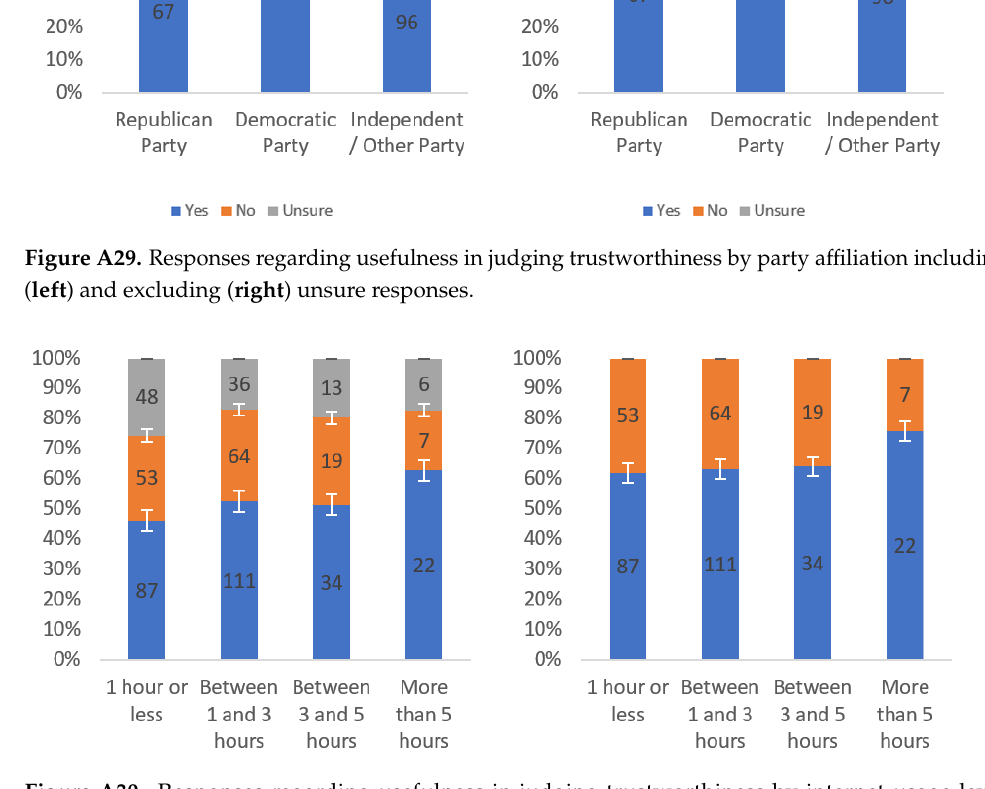
Figure A30. Responses regarding usefulness in judging trustworthiness by internet usage level including ( left ) and excluding ( right ) unsure responses.